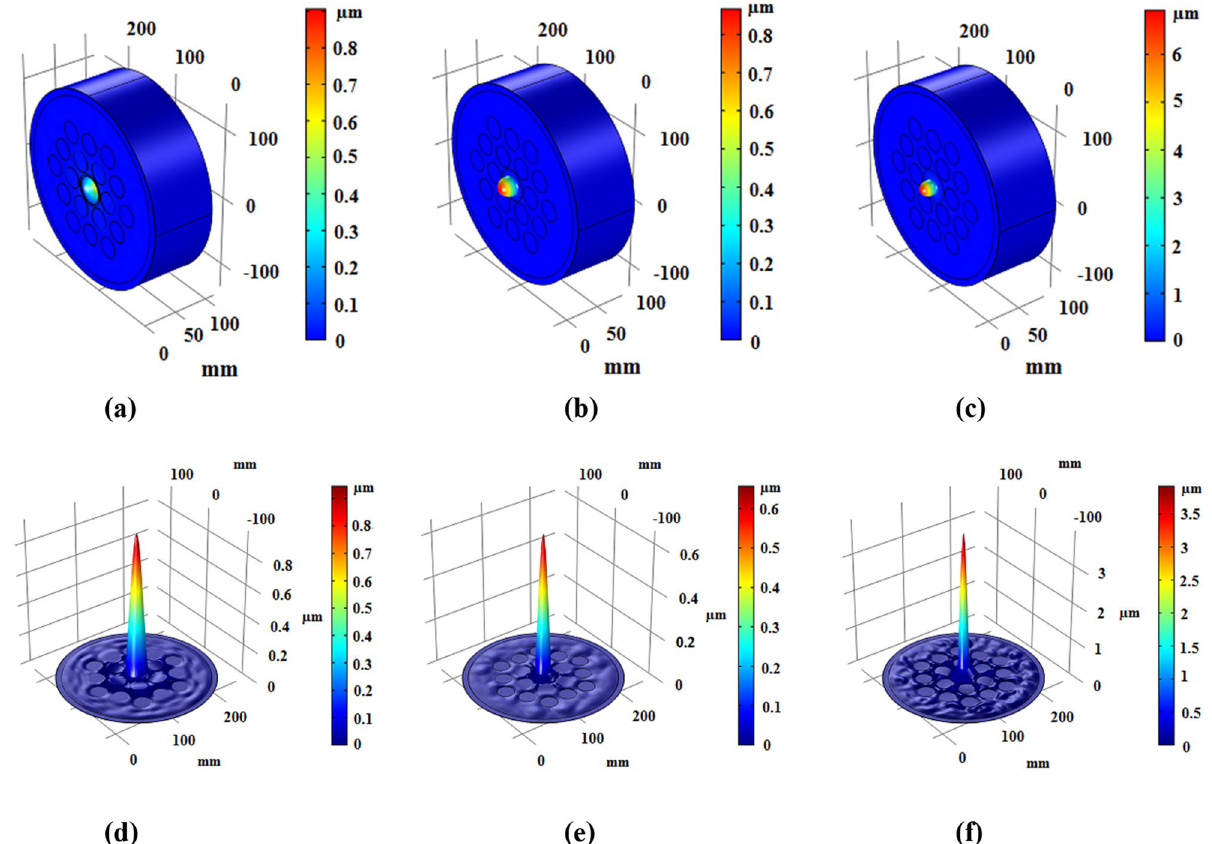
Figure 4. Displacement field of elastic wave in the phononic crystal fiber with internal radius of ( a ) r 1 , ( b ) r 2 , and ( c ) r 3 and confinement of incident wave in cross-section of fiber and in length of 90 mm (end of fiber) for ( d ) r 1 , ( e ) r 2 , and ( f ) r 3